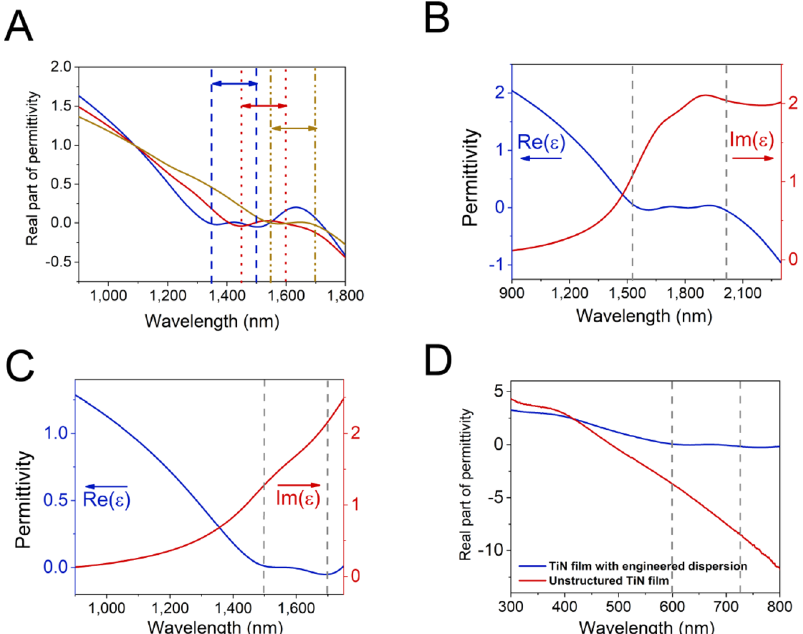
Figure 4: General applicability of